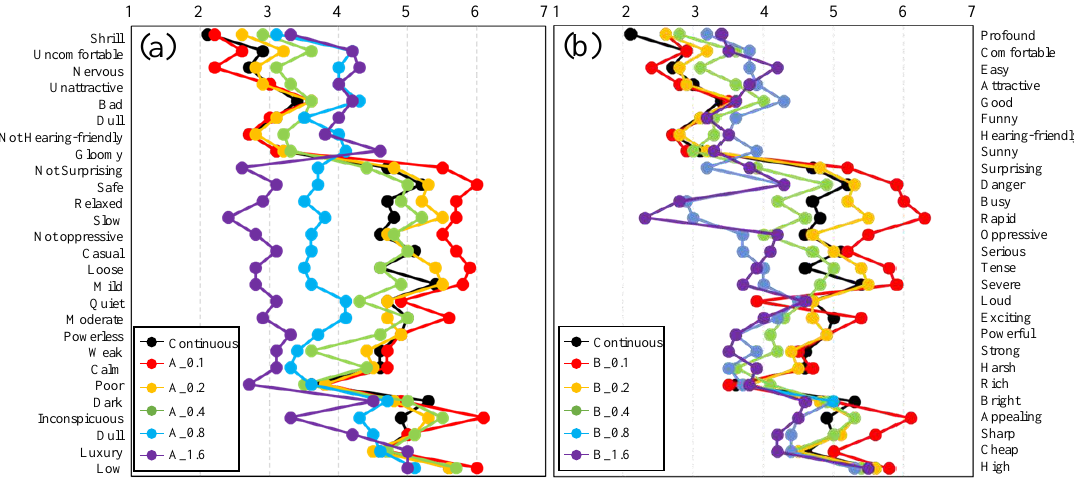
Figure 8. Average profile ratings obtained by the SD test for ( a ) Pattern A and ( b ) Pattern B. Table 6. Experimental results of factor analysis in case of Phase 2.